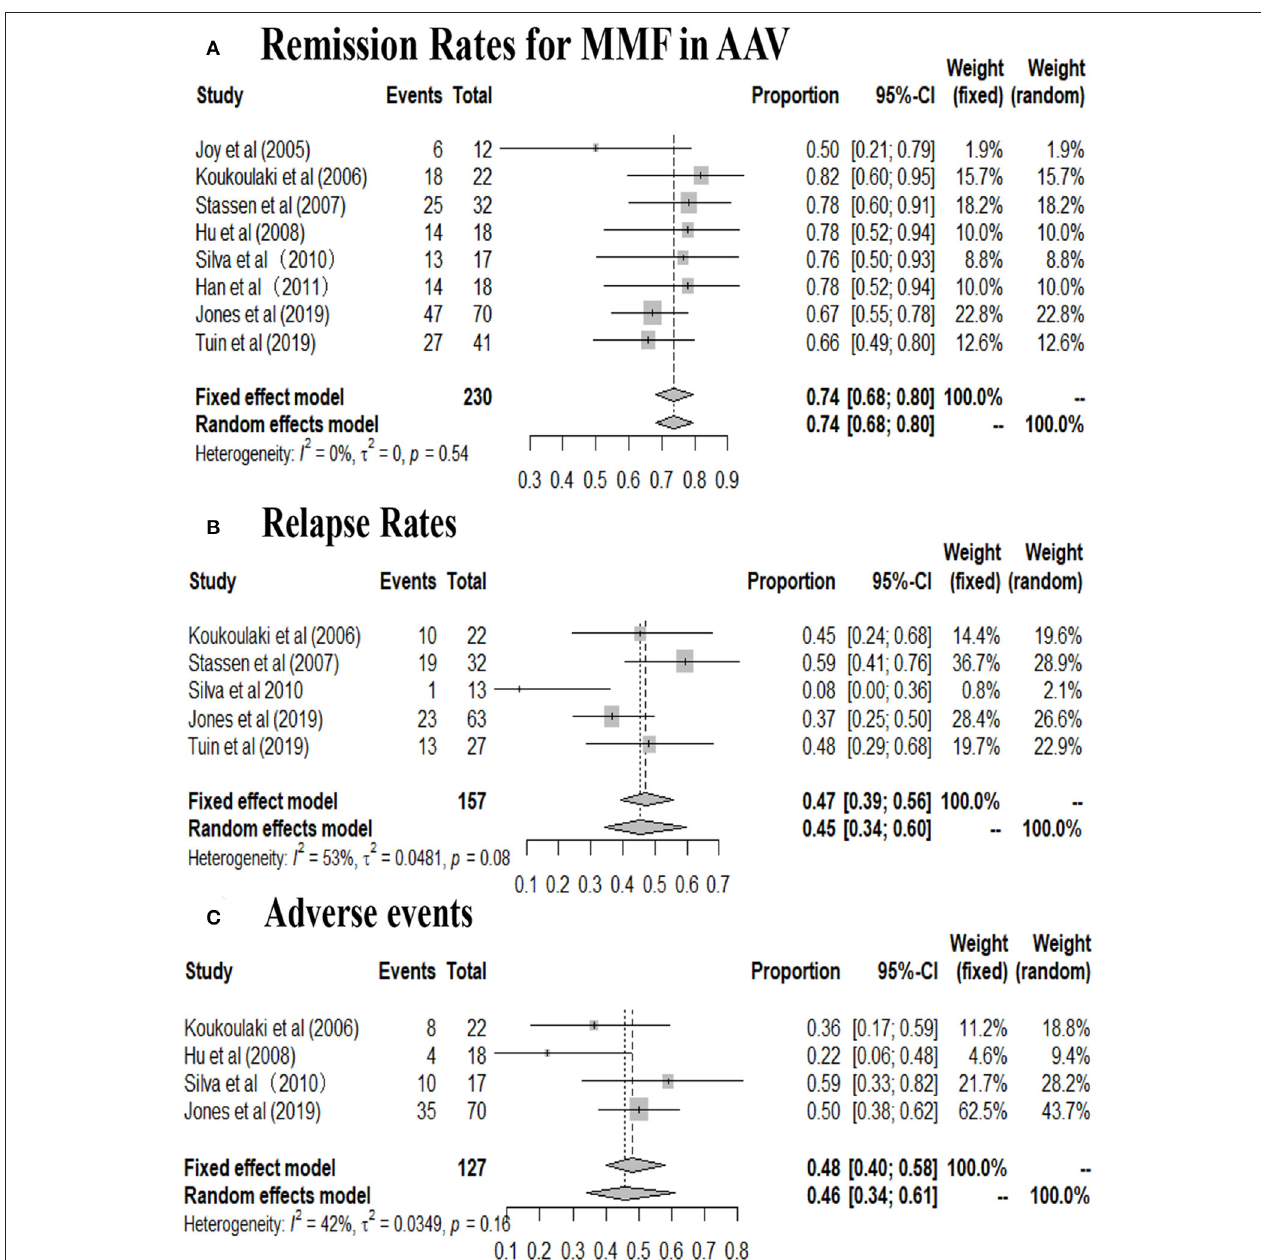
FIGURE 2 | (A) Remission rates, (B) relapse rates, and (C) adverse events in patients undergoing MMF treatment in the included studies (By R software).